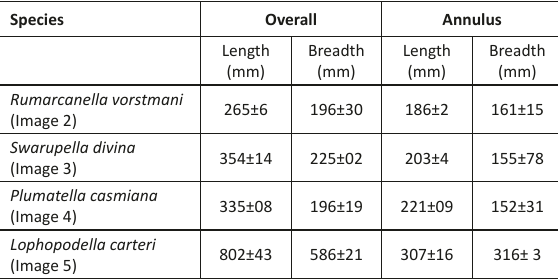
Table 2. Statoblast dimensions (length and breadth of statoblast and